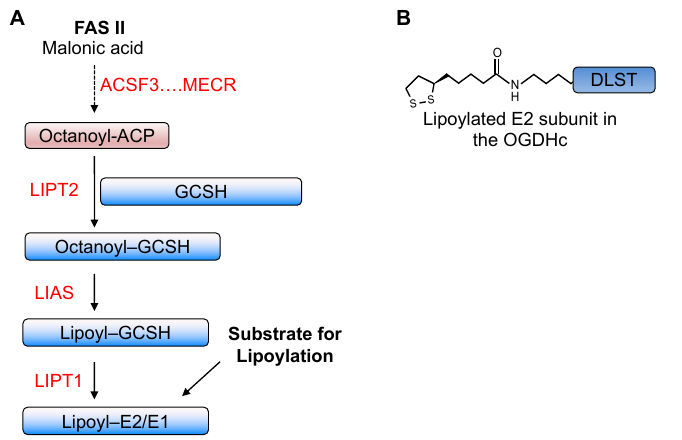
Figure 2. Mitochondrial protein lipoylation. ( A ) Schematic of the pathway involved in the formation of lipoylated proteins, highlighting some of the enzymes involved. Octanoyl-acyl carrier protein (ACP) is formed from FAS II. Acyl-CoA Synthetase Family Member 3 (ACSF3) is thought to be the first enzyme involved in this pathway. Mitochondrial enoyl-CoA reductase (MECR) is involved in the formation of acyl-ACP. Lipoylated substrates consist of the E1 and E2 subunits of the pyruvate dehydrogenase complex, the E2 subunit of the branched chain ketoacid dehydrogenase complex, and the H subunit of the glycine cleavage system (GCSH). GCSH is thought to be first octanoylated by Lipoyl(Octanoyl) Transferase 2 (LIPT2), and lipoic acid synthase (LIAS) then catalyses the formation of lipoate from the octanoylated protein. LIPT1 is thought to be involved in the transfer of the lipoate moieties to the other E1/E2 subunits. ( B ), The lipoyl moiety of dihydrolipoamide succinyltransferase (DLST) within the 2-oxoglutarate dehydrogenase complex (OGDHc) is